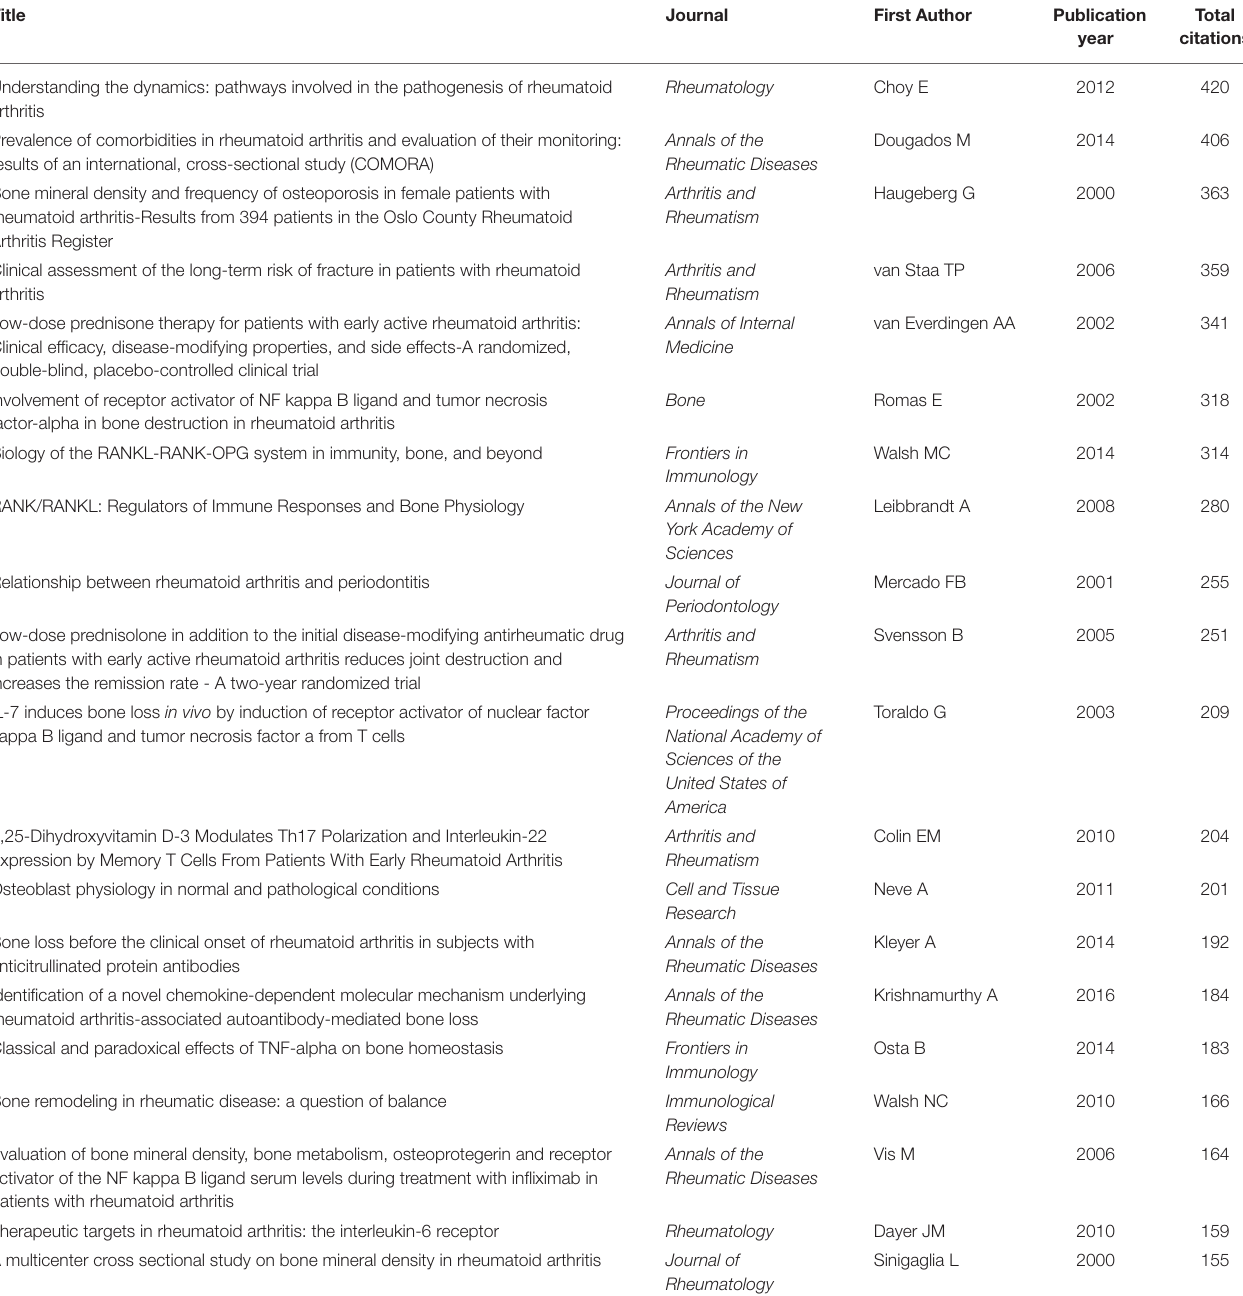
TABLE 3 | The top 20 most cited works of literature on